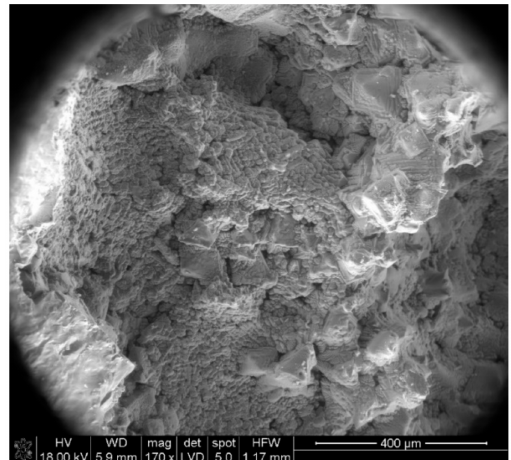
Figure 9. SEM image for the sample Sint4 at lower